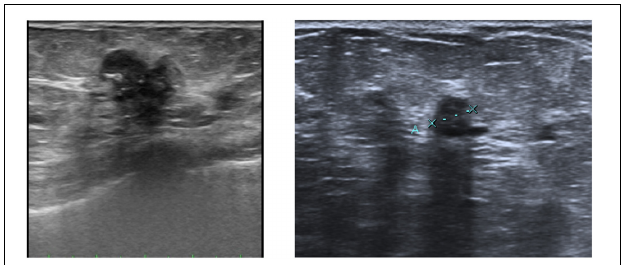
FIGURE 2 | Breast cancer ultrasound